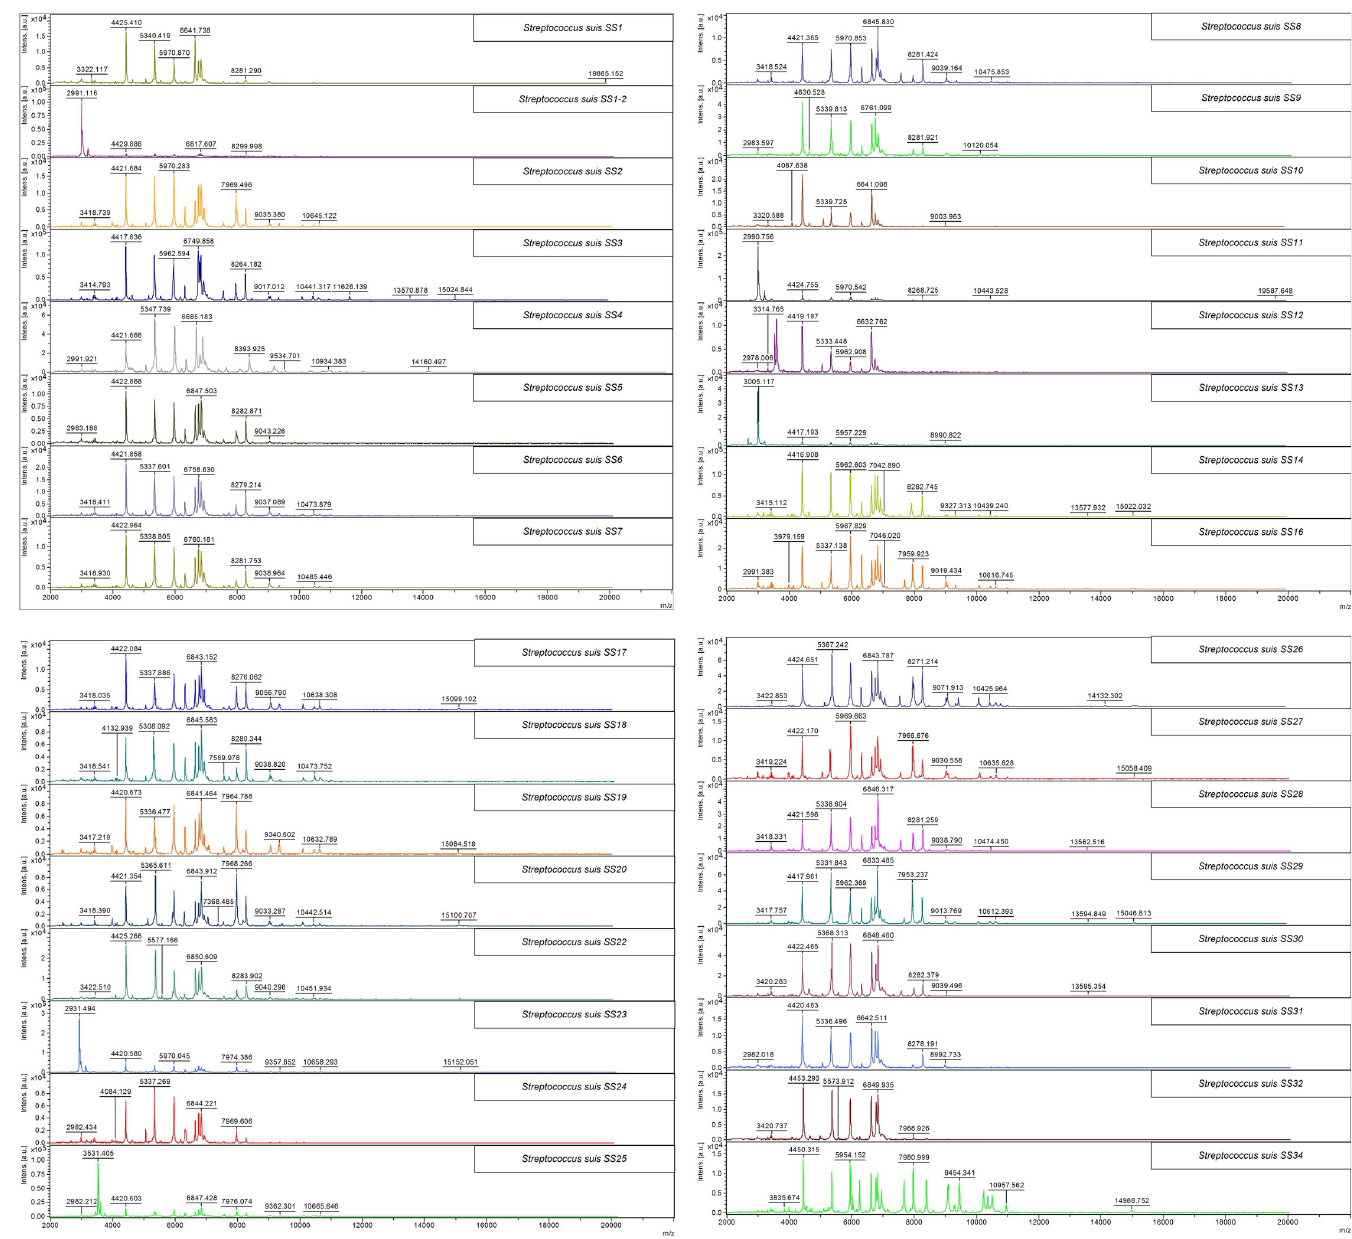
Fig 1. Representative MALDI-TOF peptide mass spectra of reference S. suis serotypes (A) SS1-7, (B) SS8-14 and SS16, (C) SS17-20 and SS22-25, and (D) SS26-32 and SS34. The X-axis represents the mass to charge ratio (m/z) and the Y-axis represents the intensity of the spectra.